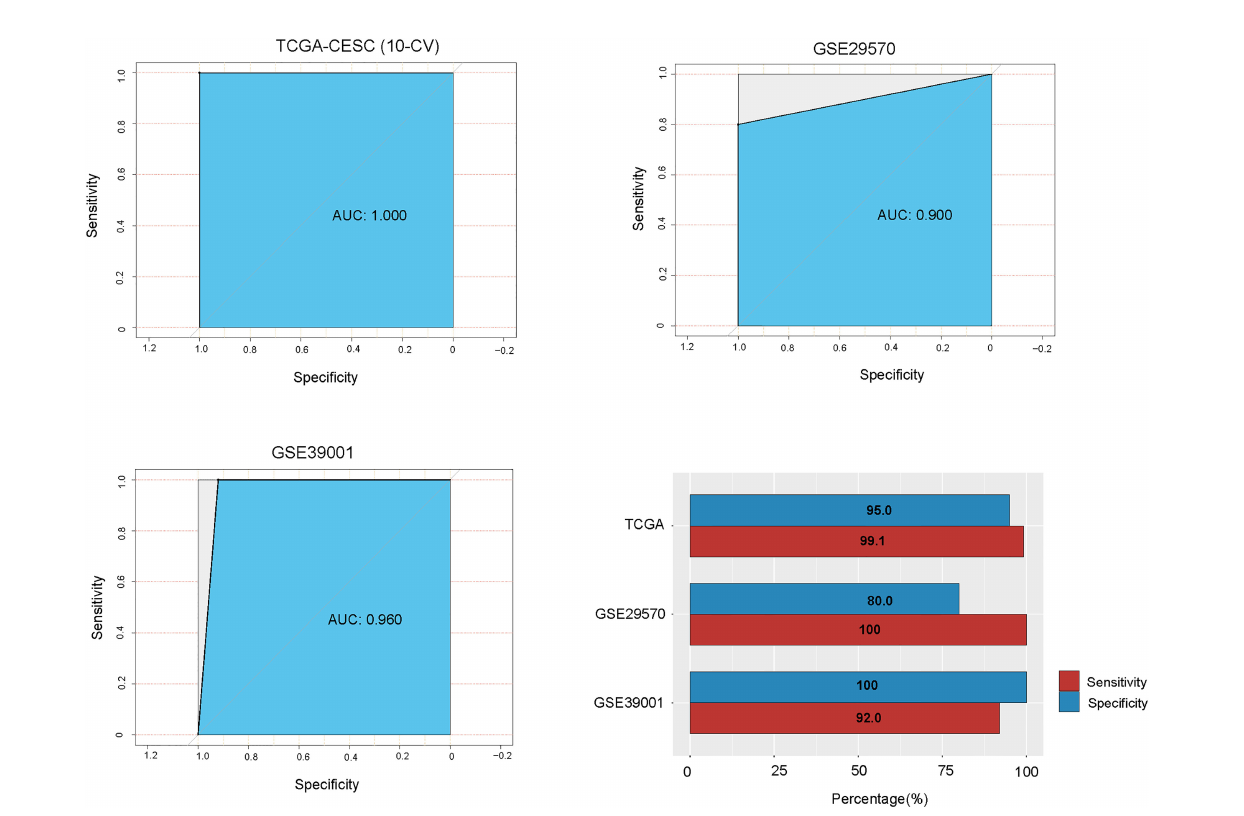
FIGURE 5 | Prediction of the HPV+ cervical cancer subtypes using the 50 genes having the largest expression variations across the TCGA HPV+ cervical cancers by random forest. TCGA-CESC was the training set and GSE29570 and GSE39001 were test sets. The sensitivity, speci fi city, and AUC are shown. AUC, area under the receiver operating characteristic curve; CV, cross